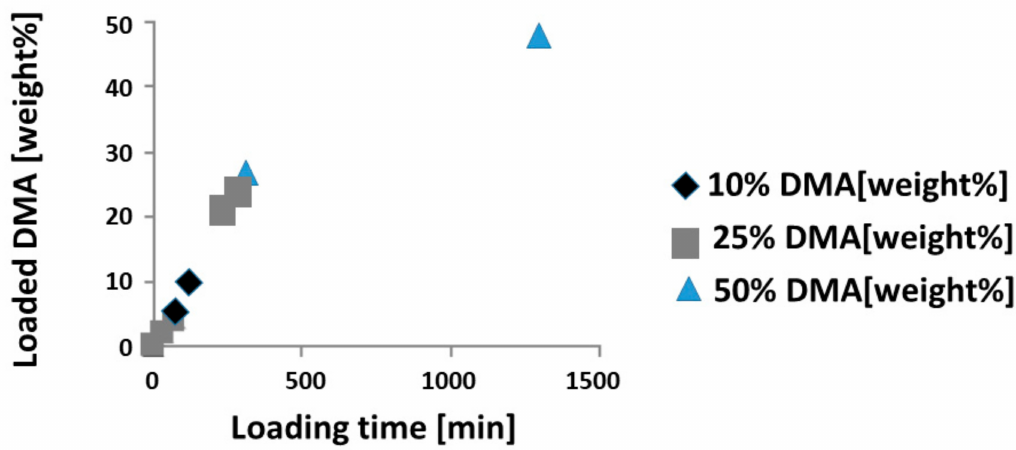
Figure 1. Vapor deposition of N,N -Dimethylacetamide (DMA). Vapor deposition up to 22 h is presented. A total of 1320 min are needed to reach 50 wt % DMA loading. Black diamonds indicate loading for the vapor 10% sample, which needs 120 min. The dark grey squares represent the vapor 25% sample, needing 300 min. Light blue triangles depict the loading curve for the vapor 50%